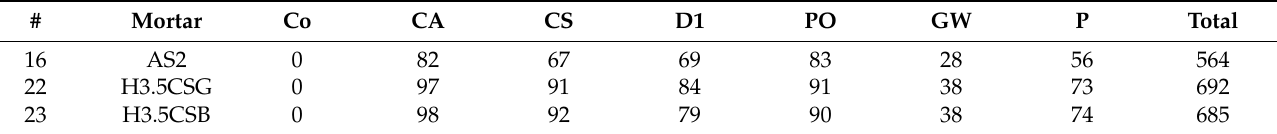
Table 14. Scores for selected mortars for the Calakmul stone with weighed coefficients (Equation